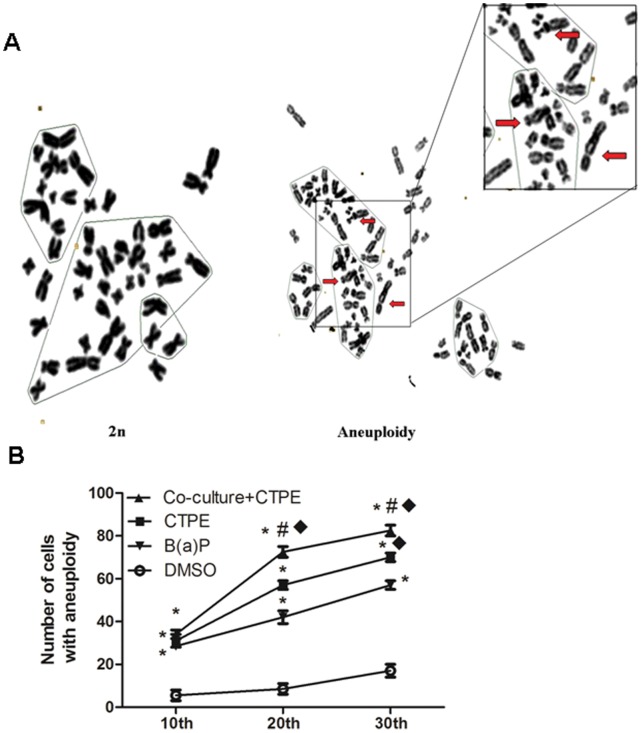
The number of BEAS-2B cells with aneuploidy in Co-culture/CTPE group increased at passage 10, 20 and 30.Aneulpoidy was observed based on abnormal hromosome numbers, including hypodiploid (<2n) and hyperdiploid (>2n∼<4n). (A) Representative of normal chromosome (2n) and aneuploidy (>2n). Red arrow showed double centromere. (B) The number of cells with aneuploidy in total 100 BEAS-2B cells in Co-culture/CTPE group at passage 10 was more than that of DMSO group, but was not increased compared with CTPE group. At passage 20 and 30, the rates of cells with aneuploidy in 100 BEAS-2B cells in Co-culture/CTPE group were peaked among these four groups. (n = 6, *: vs DMSO, P<0.05; #: vs CTPE, P<0.05; ♦:vs B(a)P, P<0.05.). Phenotypes were triplicated.